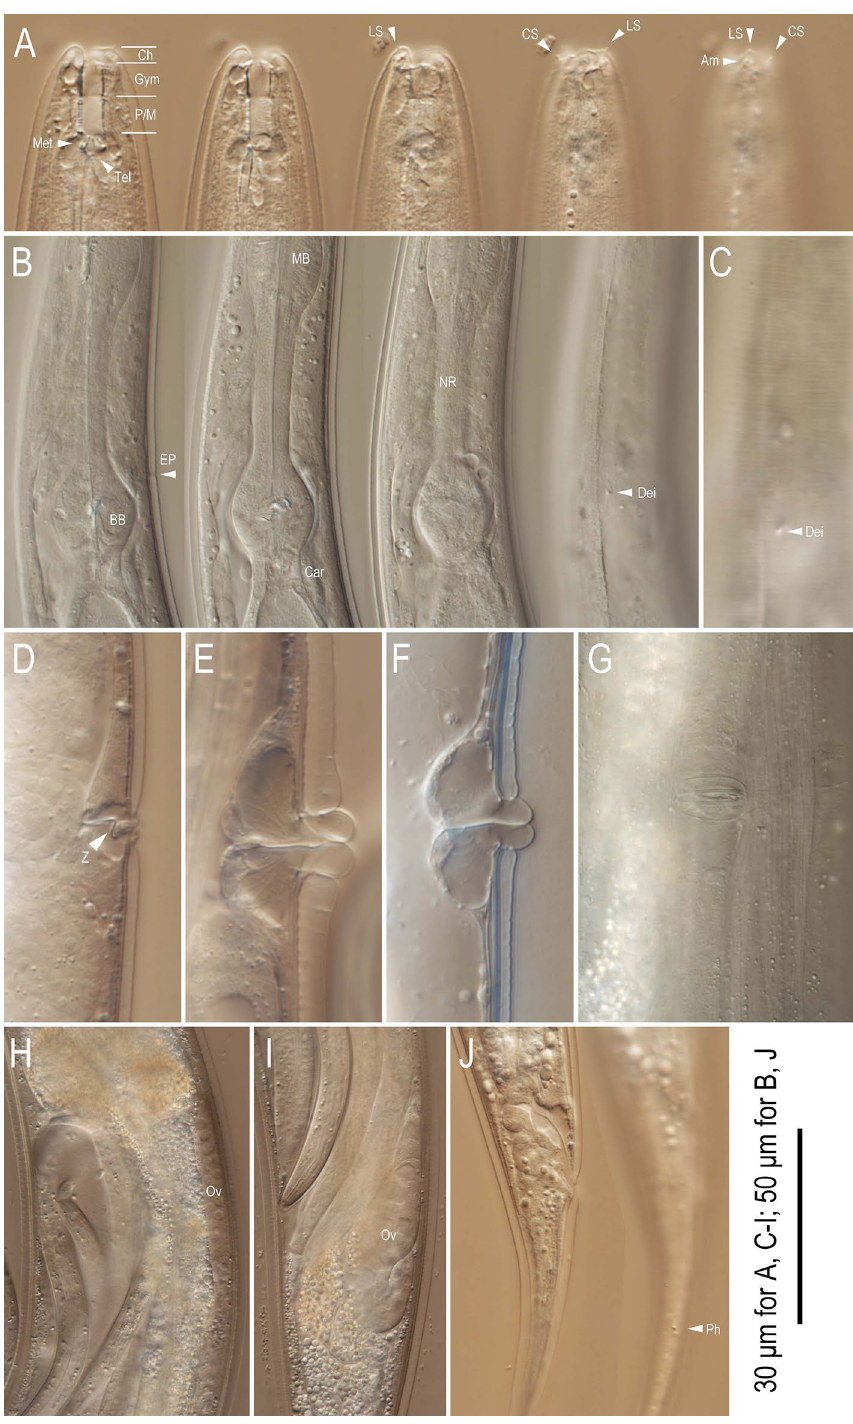
Figure 4. Adult hermaphrodite of Tokorhabditis tufae n. gen., n. sp. ( A ) Right lateral view of stoma in five different focal planes; ( B ) Right lateral view of pharyngeal region in four different focal planes; ( C ) Body surface of pharyngeal region; ( D – F ) Right lateral view of vulval region of very young hermaphrodite ( D ), young hermaphrodite ( E ) and mature hermaphrodite ( F ); ( G ) Ventral view of vulval region; ( H , I ) Left lateral view of anterior ( H ) and posterior ( I ) ovaries of mature hermaphrodite; ( J ) Right lateral view of tail in two different focal planes. Abbreviations are as follows: ( A ) Ch cheilostom, Gym gymnostom, P/M pro and mesostegostom, Met metastegostom, Tel telostegostom, LS labial sensilla, CS cephalic sensilla, Am amphid; ( B , C ); Z Z-shaped vaginal folding ( D ); MB median bulb, BB basal bulb, EP secretory-excretory pore, NR nerve ring, Dei deirid; ( H , I ) Ov ovary; ( J ) Ph